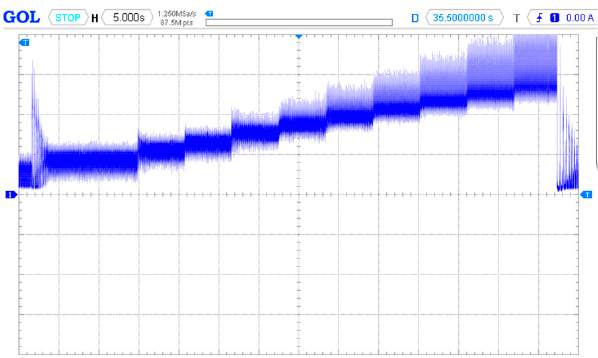
15 of 18 Figure 20. High-voltage terminal voltage. Figure 21. Low-voltage terminal voltage.